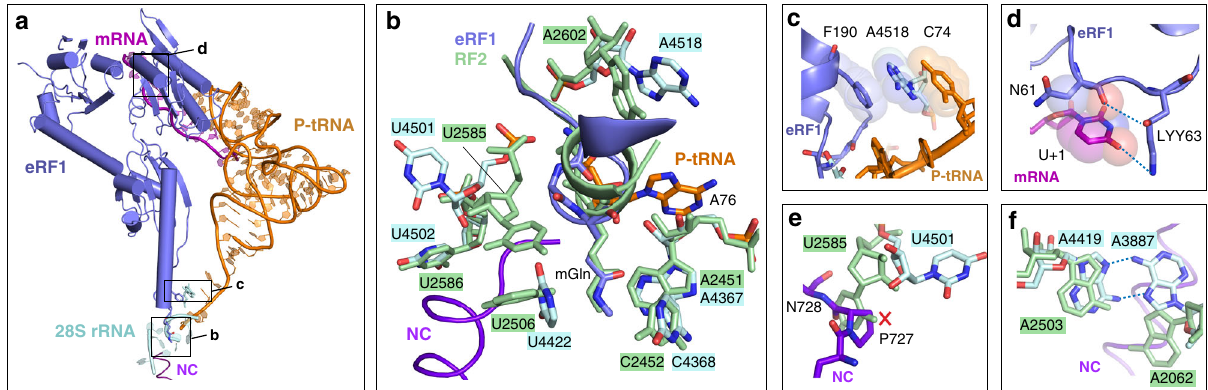
Fig. 4 PTC rearrangements in the PF846-stalled termination complex. a Overview of the mRNA decoding center and PTC with eRF1 (slate blue), P-site tRNA (orange), mRNA (magenta), 28S rRNA (light cyan), nascent chain (purple), and PF846 (cyan). Essential eRF1 motifs are highlighted in boxes with letters corresponding to the panel labels. b Comparison of the PTC from a bacterial RF2 ribosome complex (PDB code 6c5l 11 , pale green) and in the PF846- stalled termination complex. c eRF1-mediated stacking interactions within the PTC, showing eRF1 residue F190, 28S rRNA nucleotide A4518, and C74 of P- site tRNA. Spheres represent van der Waals radii of C, N, and O atoms. d Interaction network of U + 1 in the UAA stop codon (magenta) with the eRF1 NIKS motif (slate blue). Interactions proposed to stabilize the stop codon are indicated with dashed lines for hydrogen bonds and spheres for van der Waals radii. 4 R -hydroxylysine (LYY63) at residue 63 in eRF1 is shown. e Comparison of the position of 28S rRNA nucleotide U4501 with Ec 23S rRNA nucleotide U2585 in the RF2-bound bacterial ribosome. The steric clash with the PF846-stalled NC is highlighted with a red “ X ” . f Comparison of the positions of A3887 and A4419 with the respective nucleotides in the RF2-bound bacterial ribosome ( Ec A2062 and U2503), showing dashed lines for hydrogen